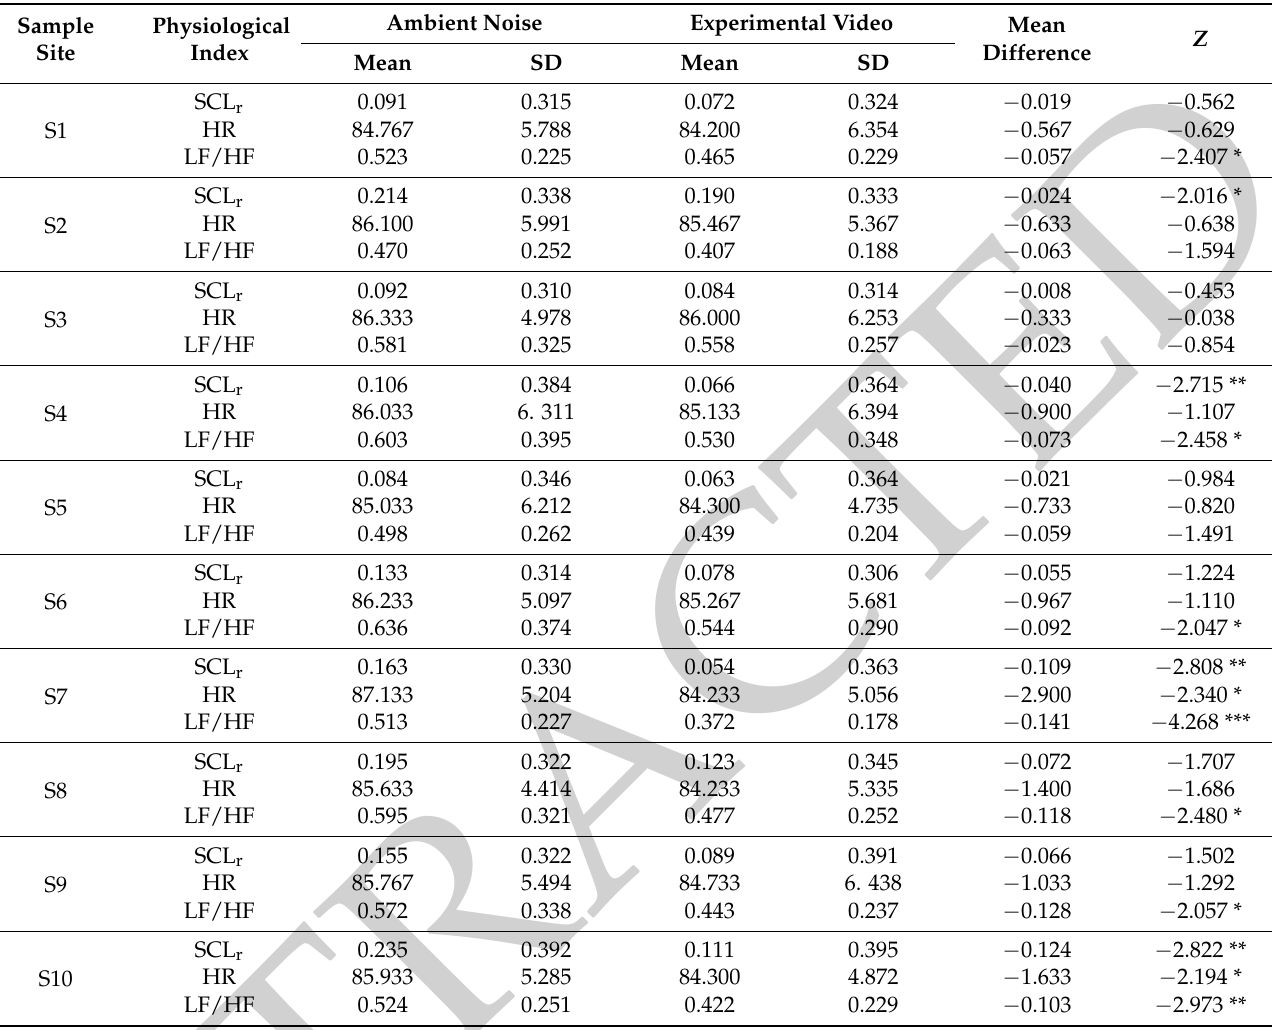
Table 3. Differences in physiological indexes between the ambient noise phase and the experimental video phase.